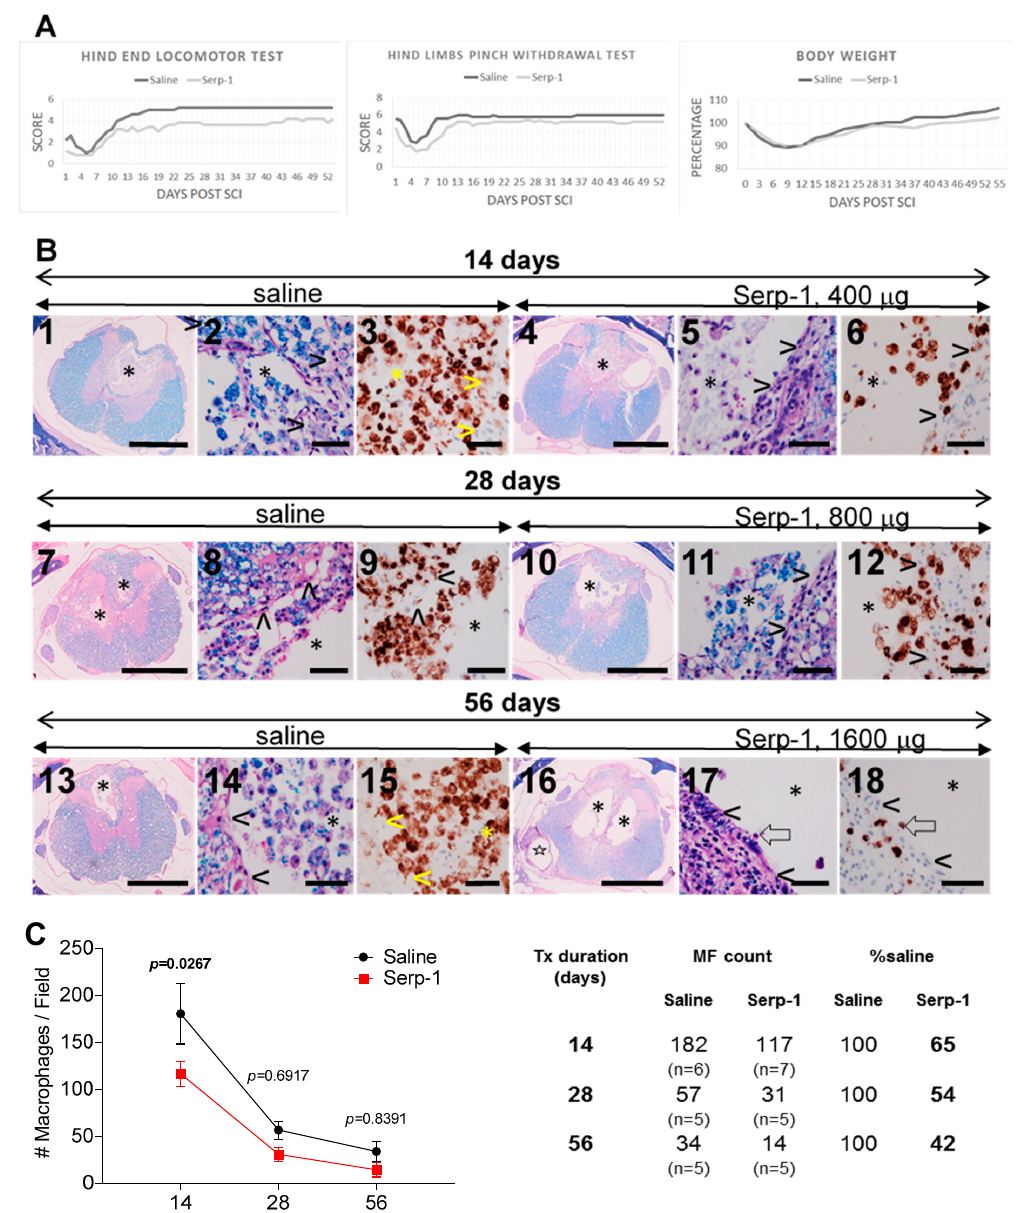
Figure 2. Effect of Serp-1 in 56 days treatment. ( A ) Clinical scores. The clinical scores in the hind end locomotor test and in the hind limb pinch withdrawal test for Serp-1 treatment were performed daily during the 56 day study. At 28 days post-SCI the spent 2ML4 pump was replaced with a fresh 2ML4 pump with the same amount of Serp-1 or saline and maintained for additional 28 days, total 56 days infused with a total of 1.6 mg Serp-1. There is no beneficial effect of Serp-1 infusion. The stabilization of scores during the 4th week for the hind end locomotor test and during the 3rd week for the hind limb pinch withdrawal test does not reflect the severe pathology observed histologically during the remaining 4–5 weeks of the study. The body weights, taken every 3rd day are expressed as % of pre-surgical body weight for each rat and averaged. ( B ) Histologic analysis. The low magnification micrographs for the saline (1,7,13) and for Serp-1 (4,10,16) infusion show cavities of injury (COI, * ) delineated by spinal cord ( > ) in high magnification micrographs. The COI contain multiple large phagocytic cells with internalized blue granules of myelin and / or red blood cells. A large proportion of cells in the COI are positive for CD68 + antibody (brown color) and are consistently more numerous in the saline treatment than in the Serp-1 treatment. Myelin-rich necrotic debris are not evident between phagocytic cells in saline-treated rats but abundant at 14 and 28 days although not at 56 days